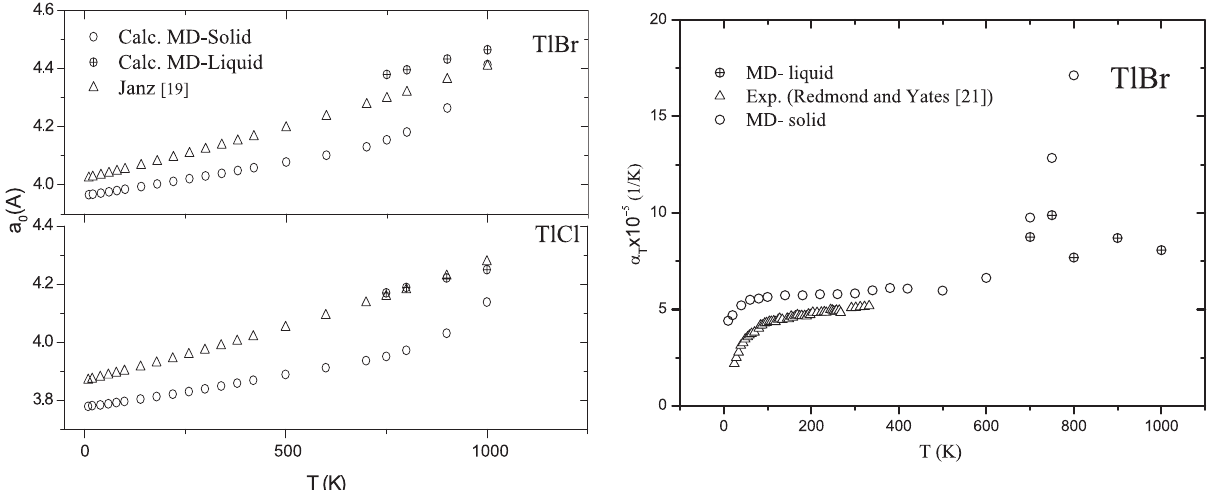
Fig. 2: Linear thermal expansion coefficient for TlBr.